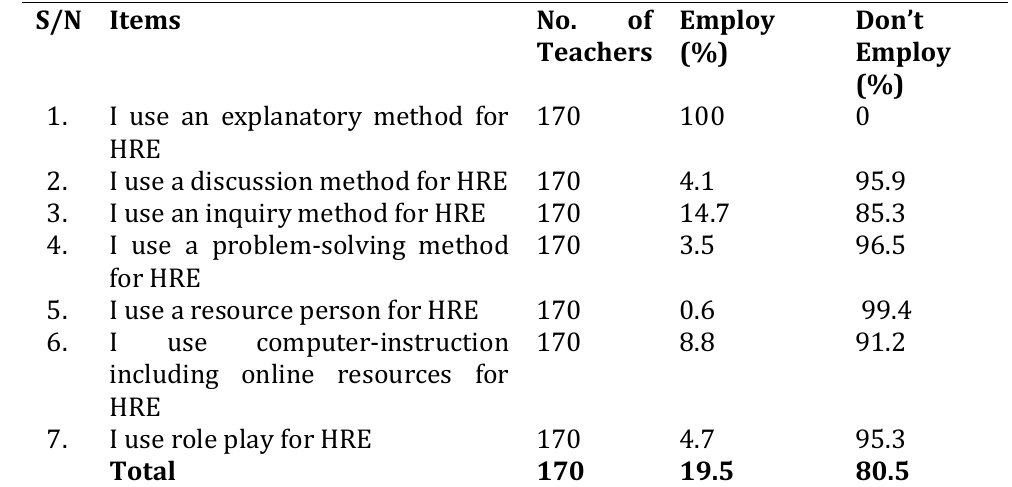
Table 4: Percentage of instructional methods employed by teachers in teaching human rights contents of